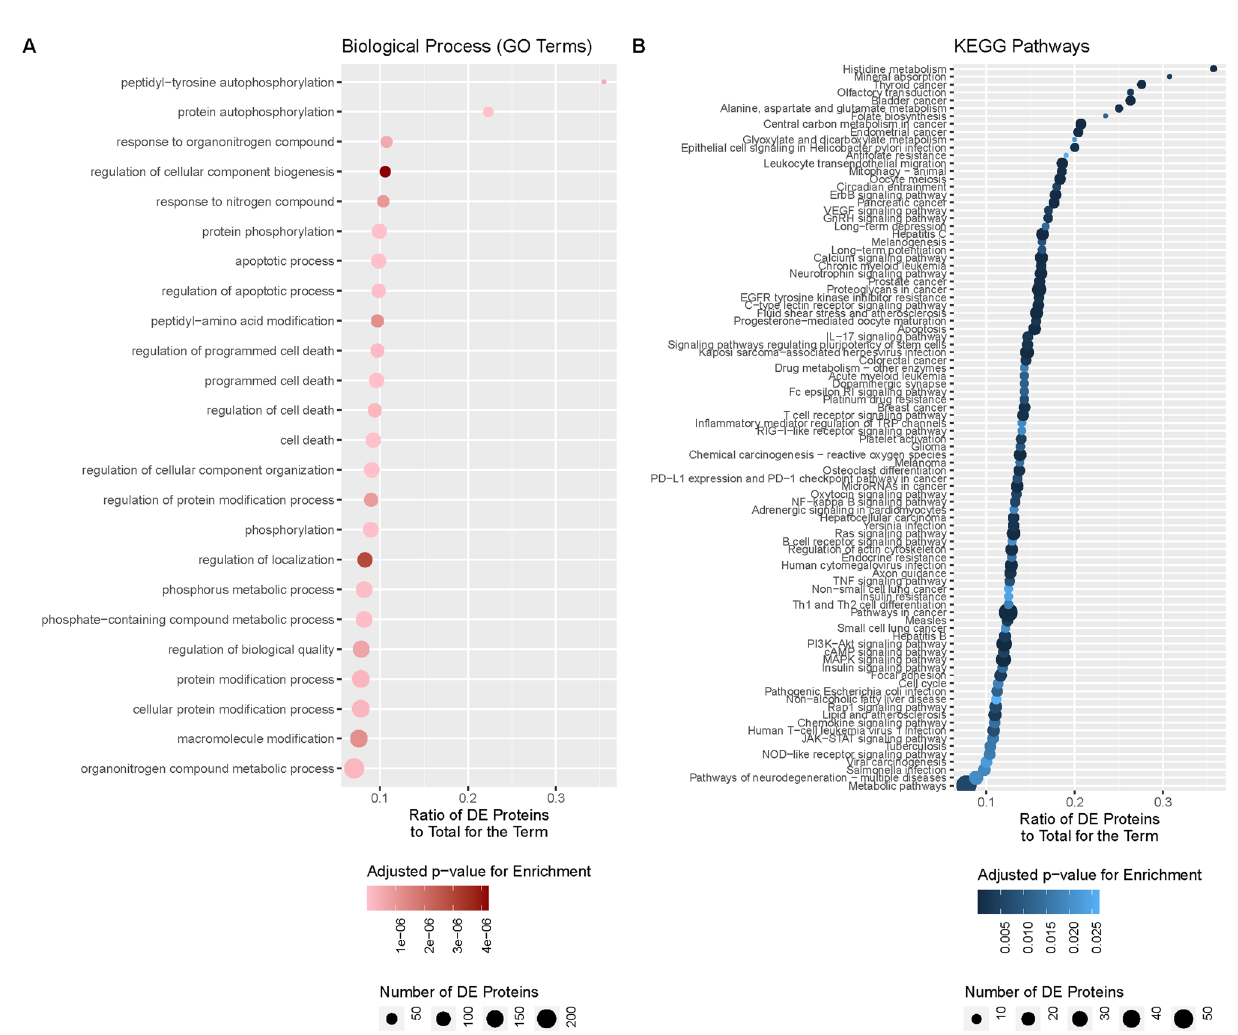
Figure 3. Biological processes related to predicted homologous proteins. Over enriched GO terms (A) and over enriched KEGG Pathways (B) are shown here. These show which terms and pathways are overrepresented in our set of 346 proteins which have significant structural homology to a SARS-CoV-2 protein. Terms with adjusted p-values less than 0.05 are shown here. The size of each dot shows the number of proteins represented in our data set which fall in that category. The color of the dot shows the adjusted p-value of the